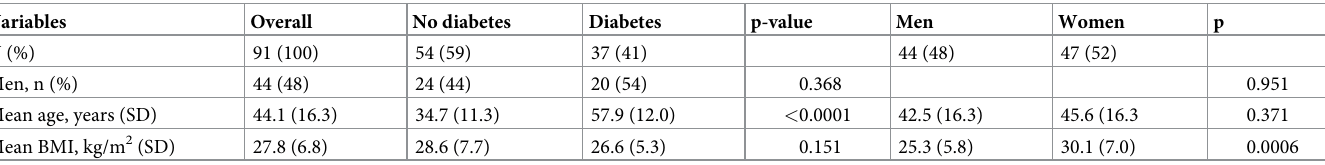
Table 2. General characteristics of the